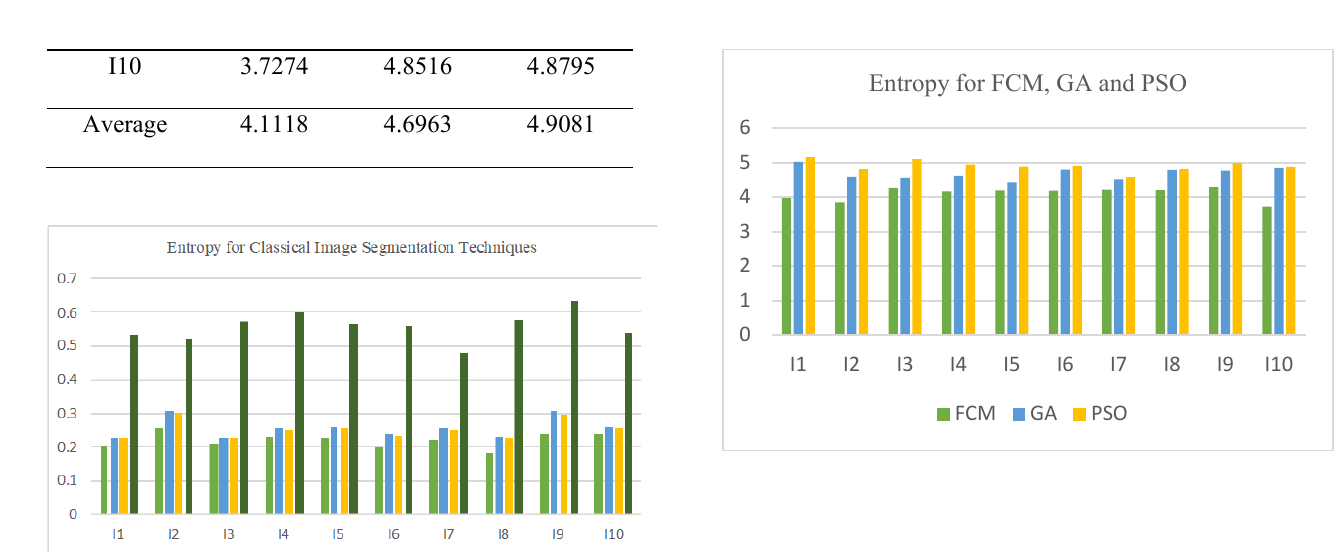
Figure 14. Entropy for FCM, GA and